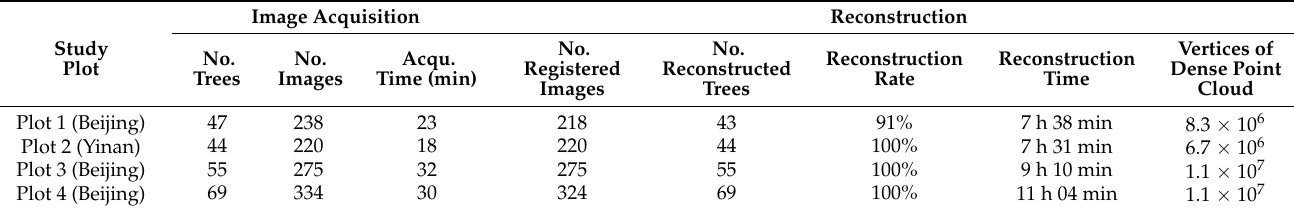
Table 2. Summary of data collection and reconstruction.